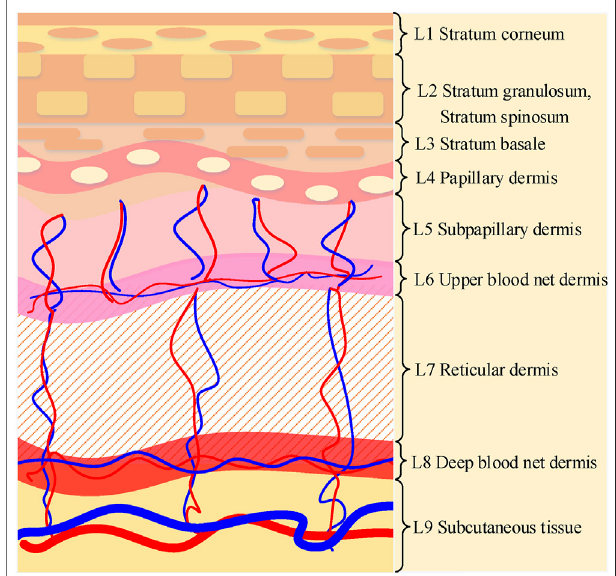
FIGURE 1 | Illustration of nine-layer structure of skin tissue: stratum corneum(L1),stratumgranulosumandstratumspinosum(L2),stratumbasale (L3), papillary dermis (L4), subpapillary dermis (L5), upper blood net dermis (L6), reticular dermis(L7), deep blood net dermis(L8) and subcutaneous tissue (L9),